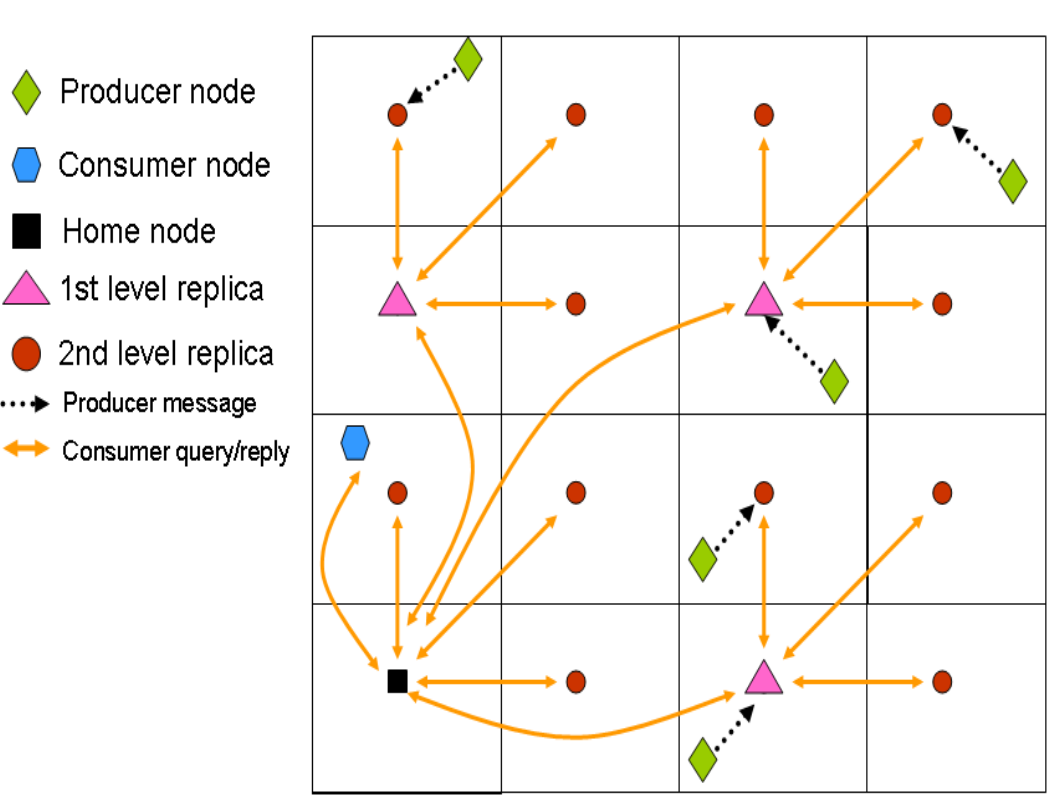
Figure 3. GHT multi-replication